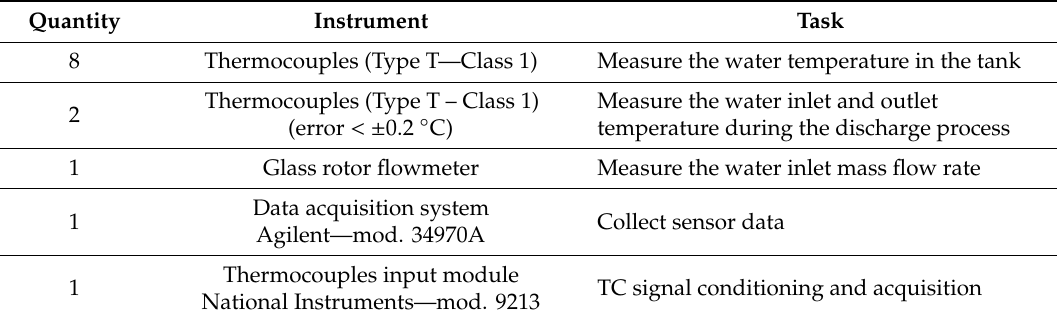
Table 3. Measurement devices used for the discharge experimental